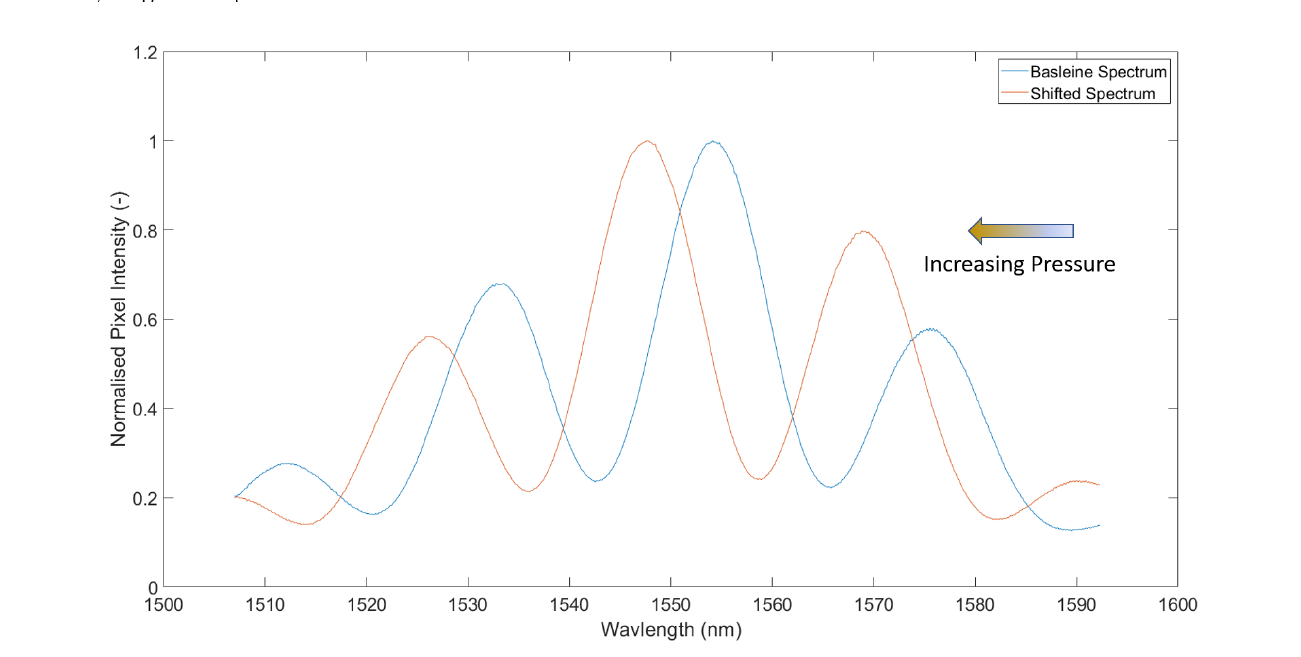
Figure 11. Example of EFPI interference pattern blue shifting as a result of decreasing cavity length due to increasing external